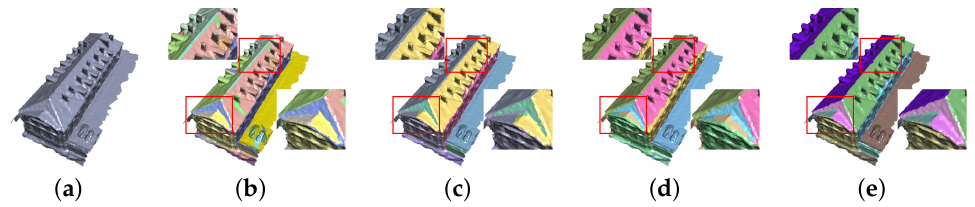
Figure 2. Comparison of segmentation results: ( a ) Original, ( b ) Oversegmentation, ( c ) Undersegmen- tation, ( d ) SABMP [11], and ( e )